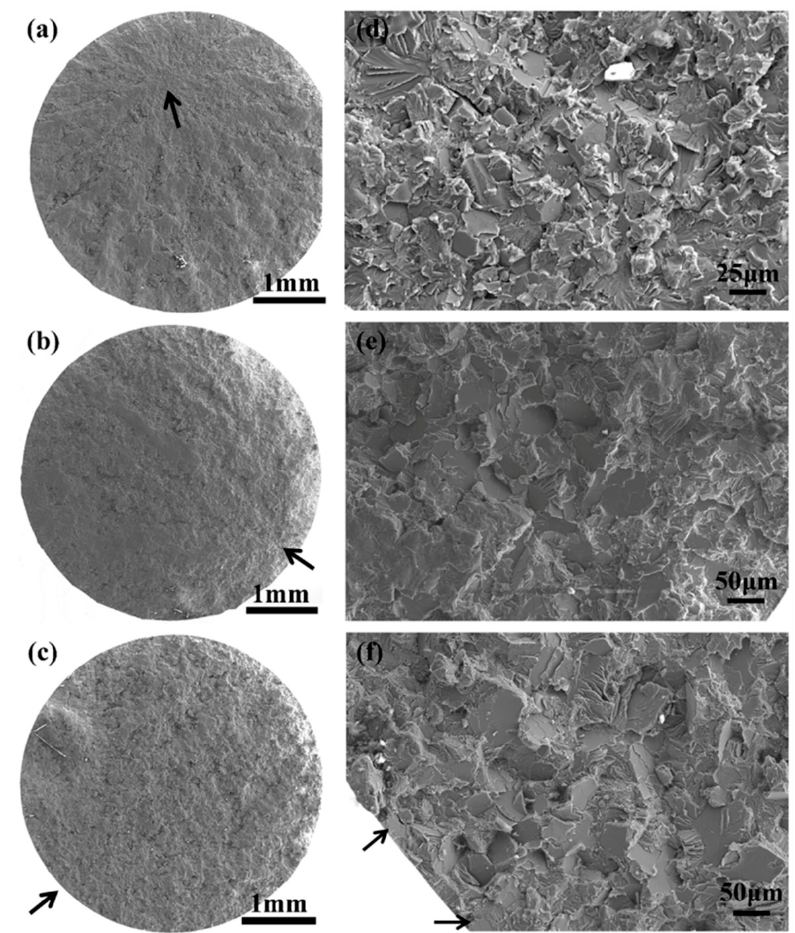
Figure 5. Fracture surfaces of fatigue tested TiAl alloys: ( a ) DP alloy, σ m = 620 MPa, N f = 4.9 × 10 6 ; ( b ) NL#1 alloy, σ m = 600 MPa, N f = 5.5 × 10 5 ; ( c ) NL#2 alloy, σ m = 560 MPa, N f = 5.7 × 10 6 . ( d ), ( e ) and ( f )